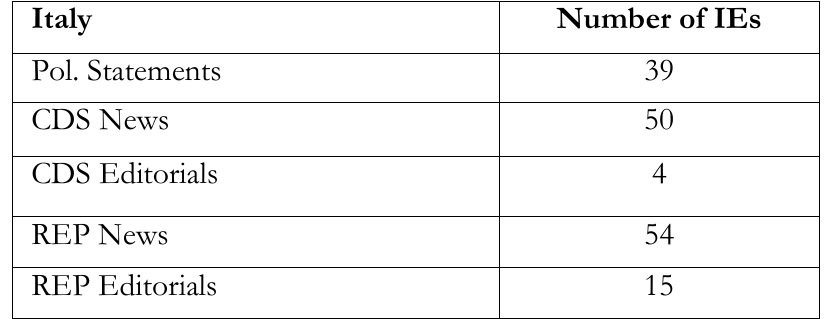
Table 3. Framing samples in the Italian political statements and media